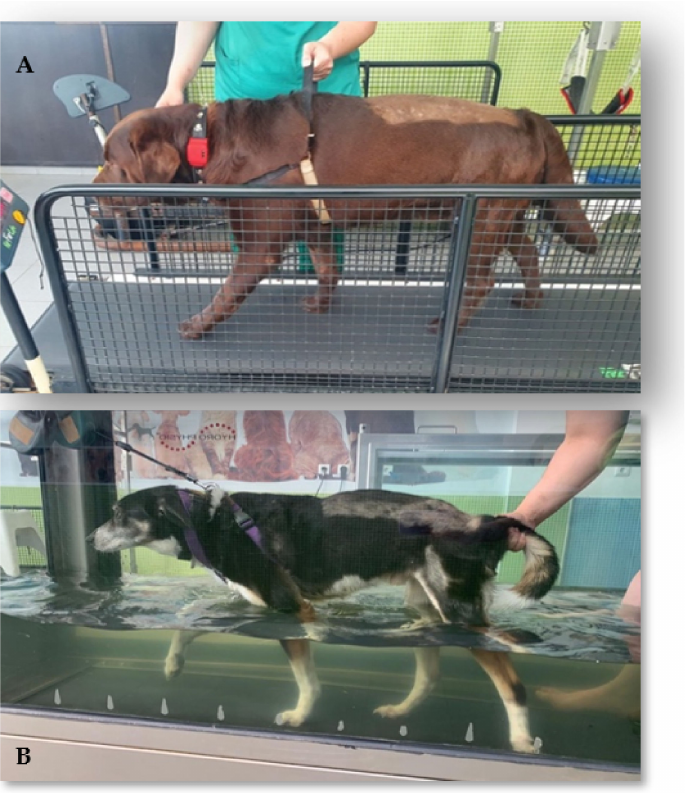
Figure 5. Locomotor exercise in two dogs. ( A ) Land treadmill; ( B ) underwater treadmill.